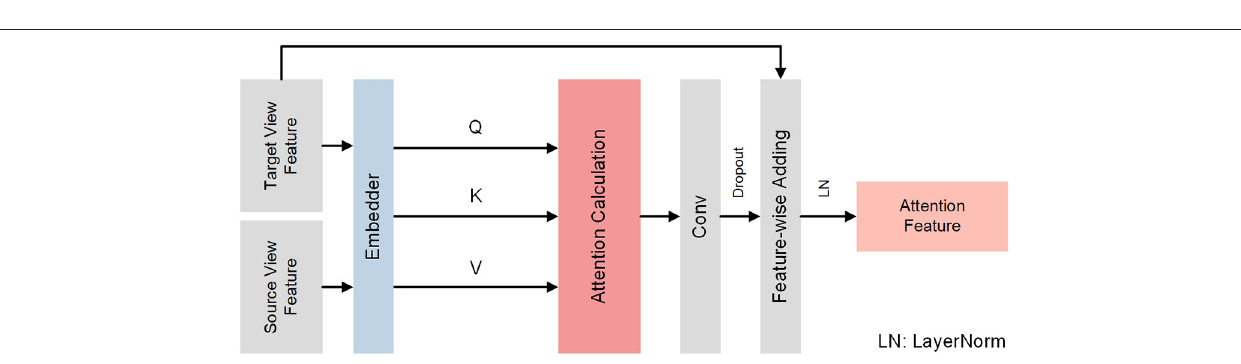
FIGURE 3 | Detailed architecture of reciprocal attention module. Reciprocal attention module receives ultrasound image pairs and generates bidirectional attention features utilizing attention mechanism